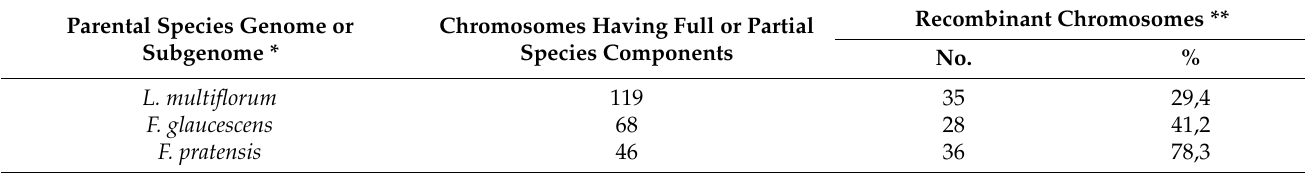
Table 3. The proportion of parental species represented in the recombinant chromosomes of donor plant F2 3-18 L. multiflorum × F. arundinacea